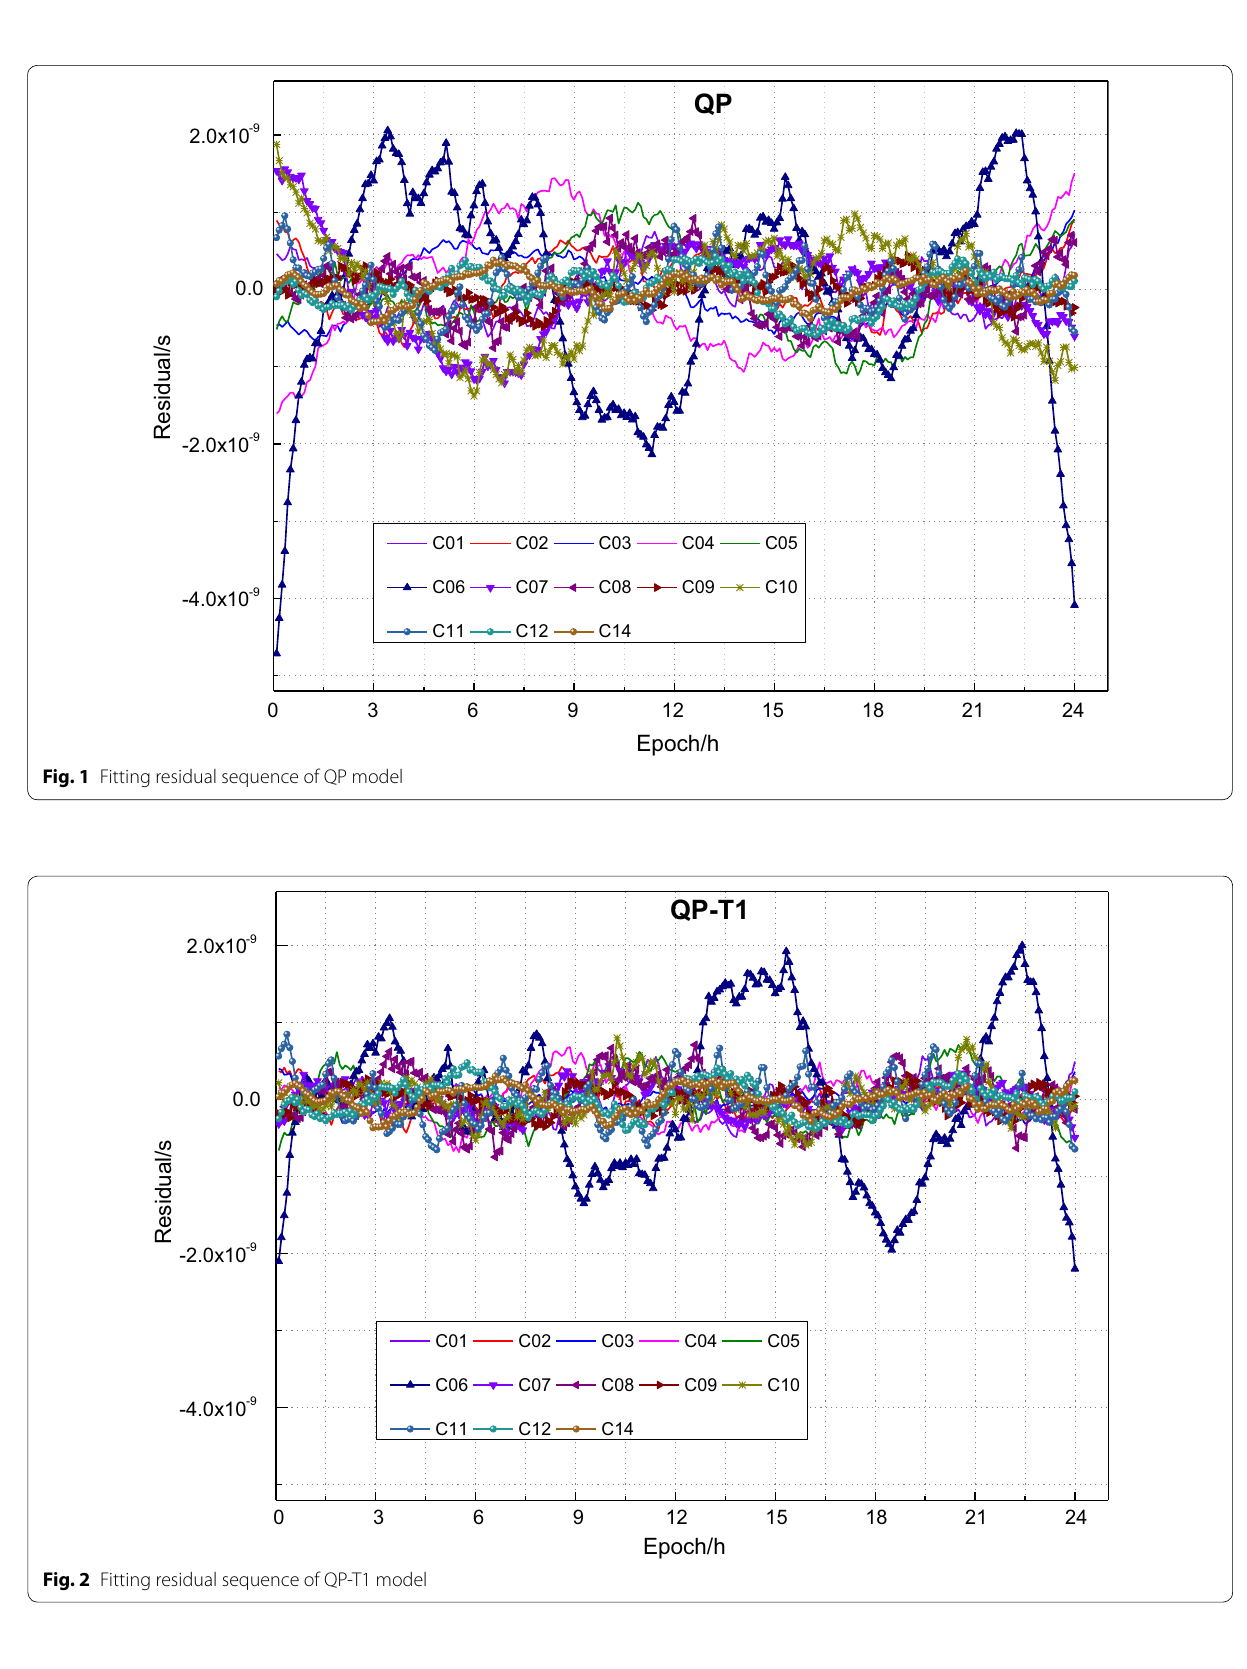
Fig. 2 Fitting residual sequence of QP-T1